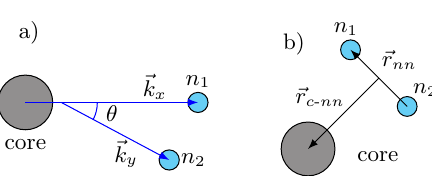
Figure 4. a) Momenta and opening angle in the Jacobi- Y repre- sentation; b) nn and core- nn distances in the Jacobi- T represen-